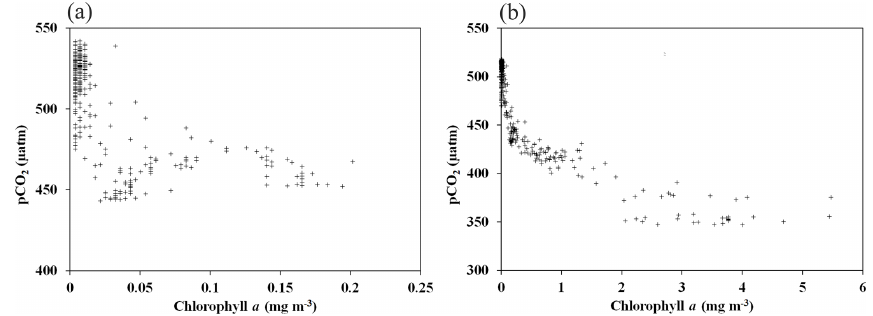
Figure 8. Argo data were utilized to find the relationship between the chlorophyll a and the oceanic p CO 2 conditions. (a) The coefficient of correlation ( r) between the p CO 2 and chl a was found to be − 0 . 56 ( p < 0 . 01) during August–September 2017. (b) The relationship improved ( r = − 0 . 82, p < 0 . 01) during the bloom conditions in October–November